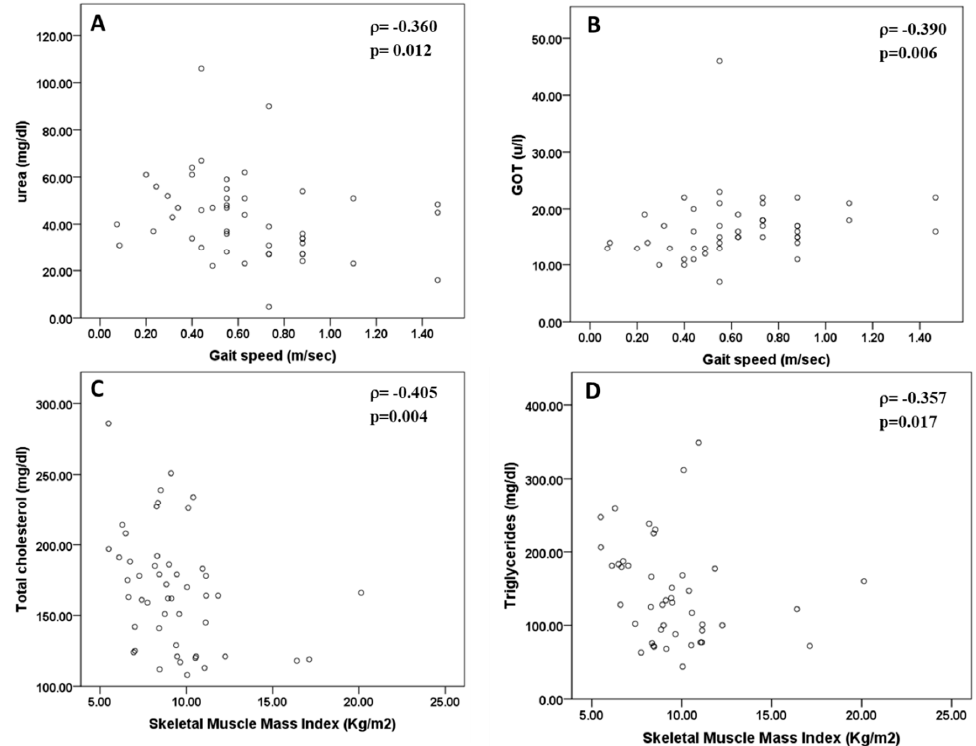
Figure 5. Correlation between skeletal muscle sarcopenia parameters and urea ( A ), GOT ( B ) and lipids (( C ): total cholesterol; ( D ): triglycerides) concentration in blood.